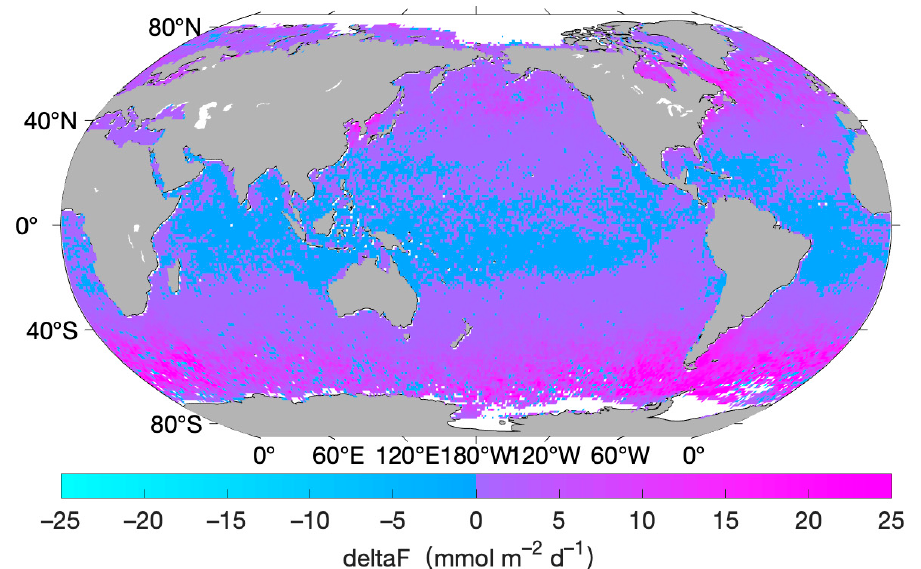
Figure 13. Regional algorithm for 2010–2020, showing the fitting results between in the ( a ) Pacific, ( c ) Atlantic, and ( e ) Indian Ocean sub-regions; and between n pCO 2wd and Chl-a in the ( b ) Pacific, ( d ) Atlantic, and ( f ) Indian Ocean sub-regions.